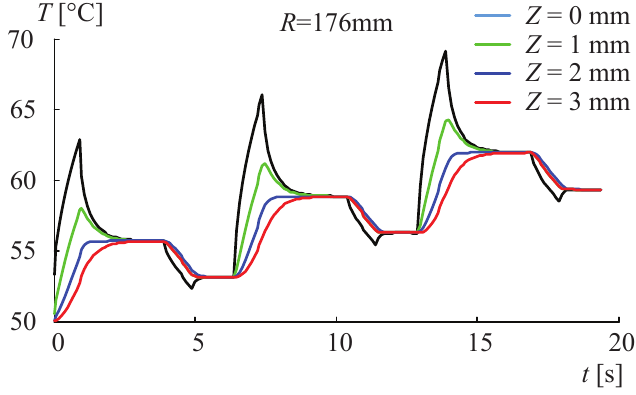
Figure 7. Temperature variation at different height on the line c